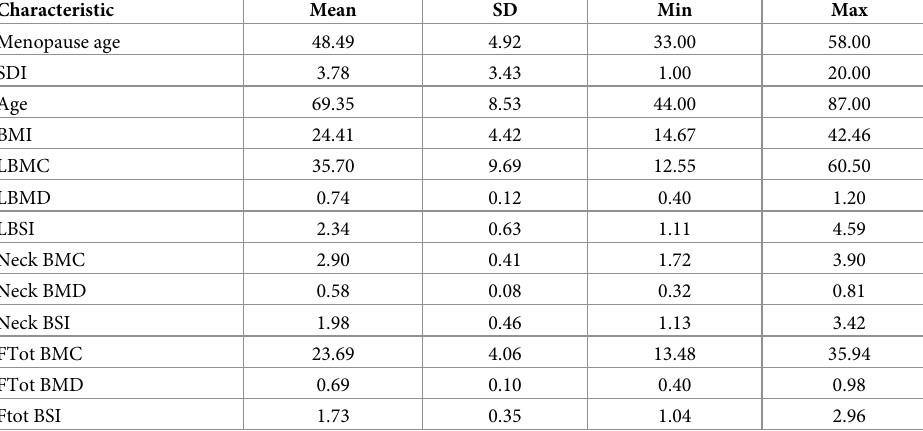
Table 1. Characteristic of the studied